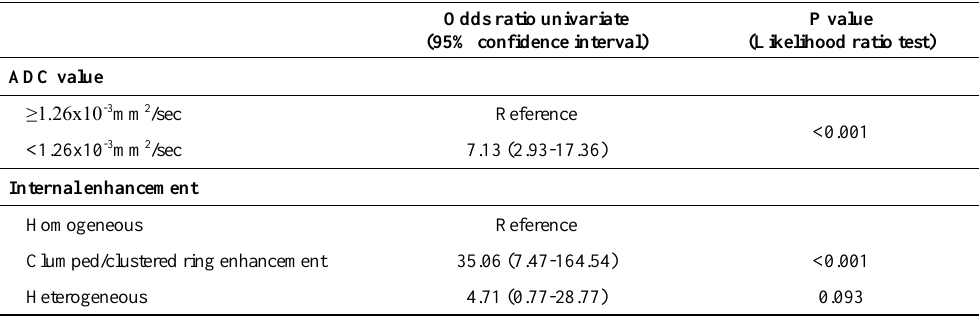
Table 3. Univariate analysis